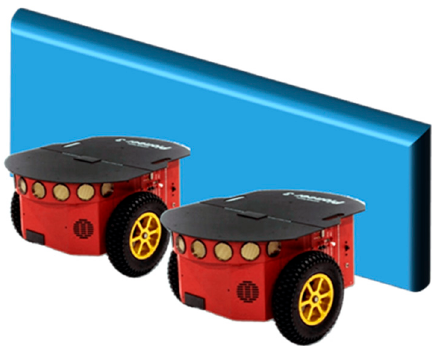
Figure 5. Illustration of two pioneer robots pushing a wide box as in [27].